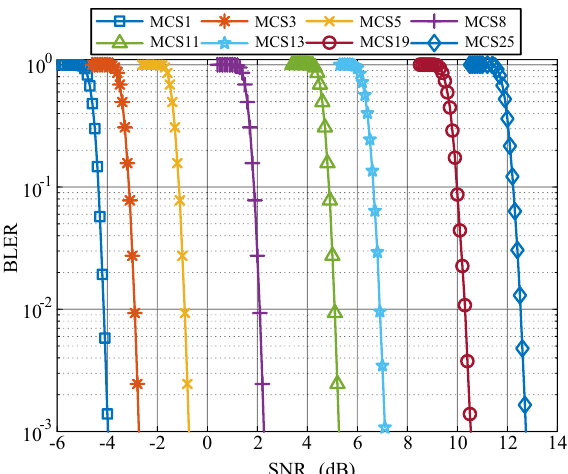
Fig. 10 BLER performance versus SNR in the AWGN